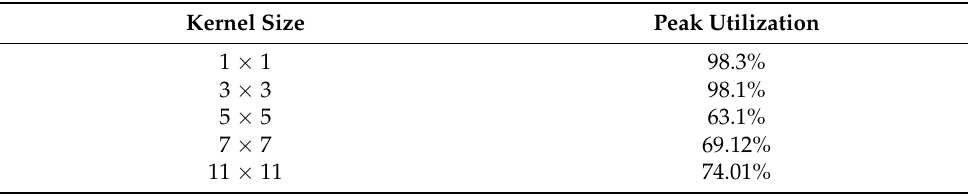
Table 1. Peak multiplier utilization for various kernel